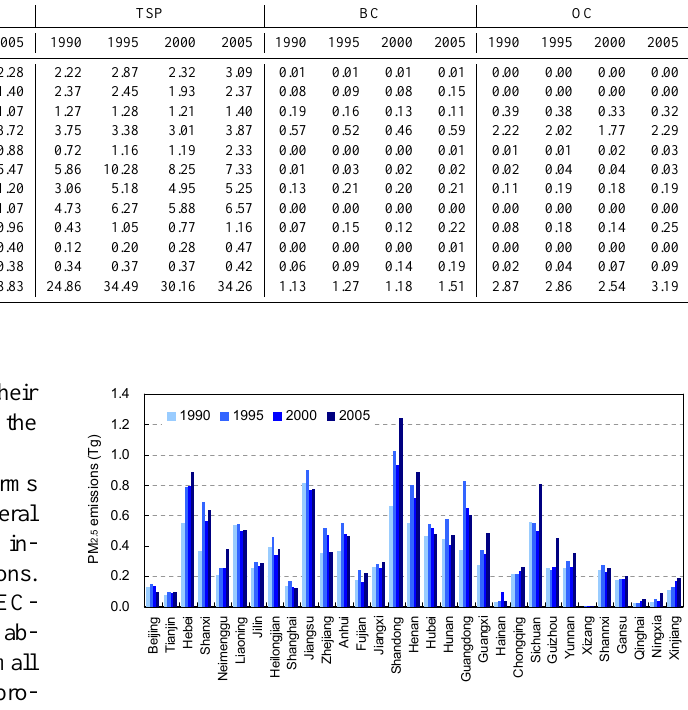
Fig. 6. Emissions of PM 2 . 5 by province for 1990, 1995, 2000 and 2005. vanced economies, such as Beijing, Shanghai, Guangdong, Jiangsu and Zhejiang, showed a reduction after 1995. This trend is due to the requirements of local government for greater environmental protection and the transition of the economy from heavy industry to high-tech and commercial sectors. However, emissions from Shandong, Hebei and Henan increased, especially after 2000, a trend consistent with the construction of many new power, cement, and iron and steel plants in these provinces. Emissions from all west- ern provinces increased after 2000, reflecting the impact of the government’s “West China Development”